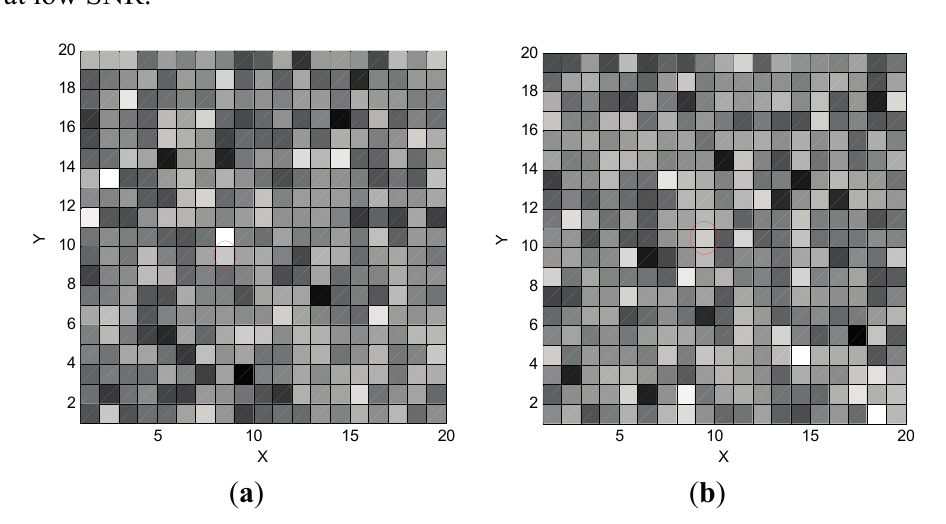
Figure 1. ( a ) Sampled image at Frame 15; ( b ) sampled image at Frame